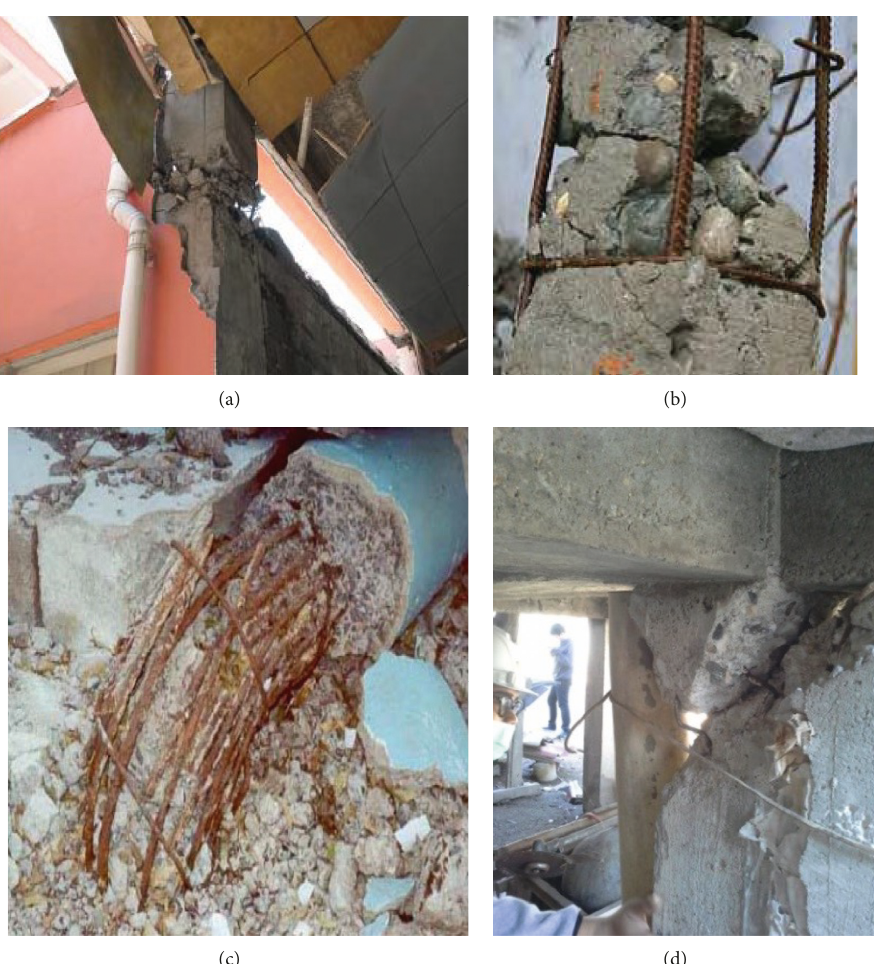
Figure 2: (a) Poor reinforcement detailing in Sichuan [20]. (b) Poor quality concrete in Sichuan [21]. (c) Collapsed column with inadequate lap splice length and widely spaced transverse bars in Gujarat, India [22]. (d) Poor reinforcement detailing in Chiang Rai